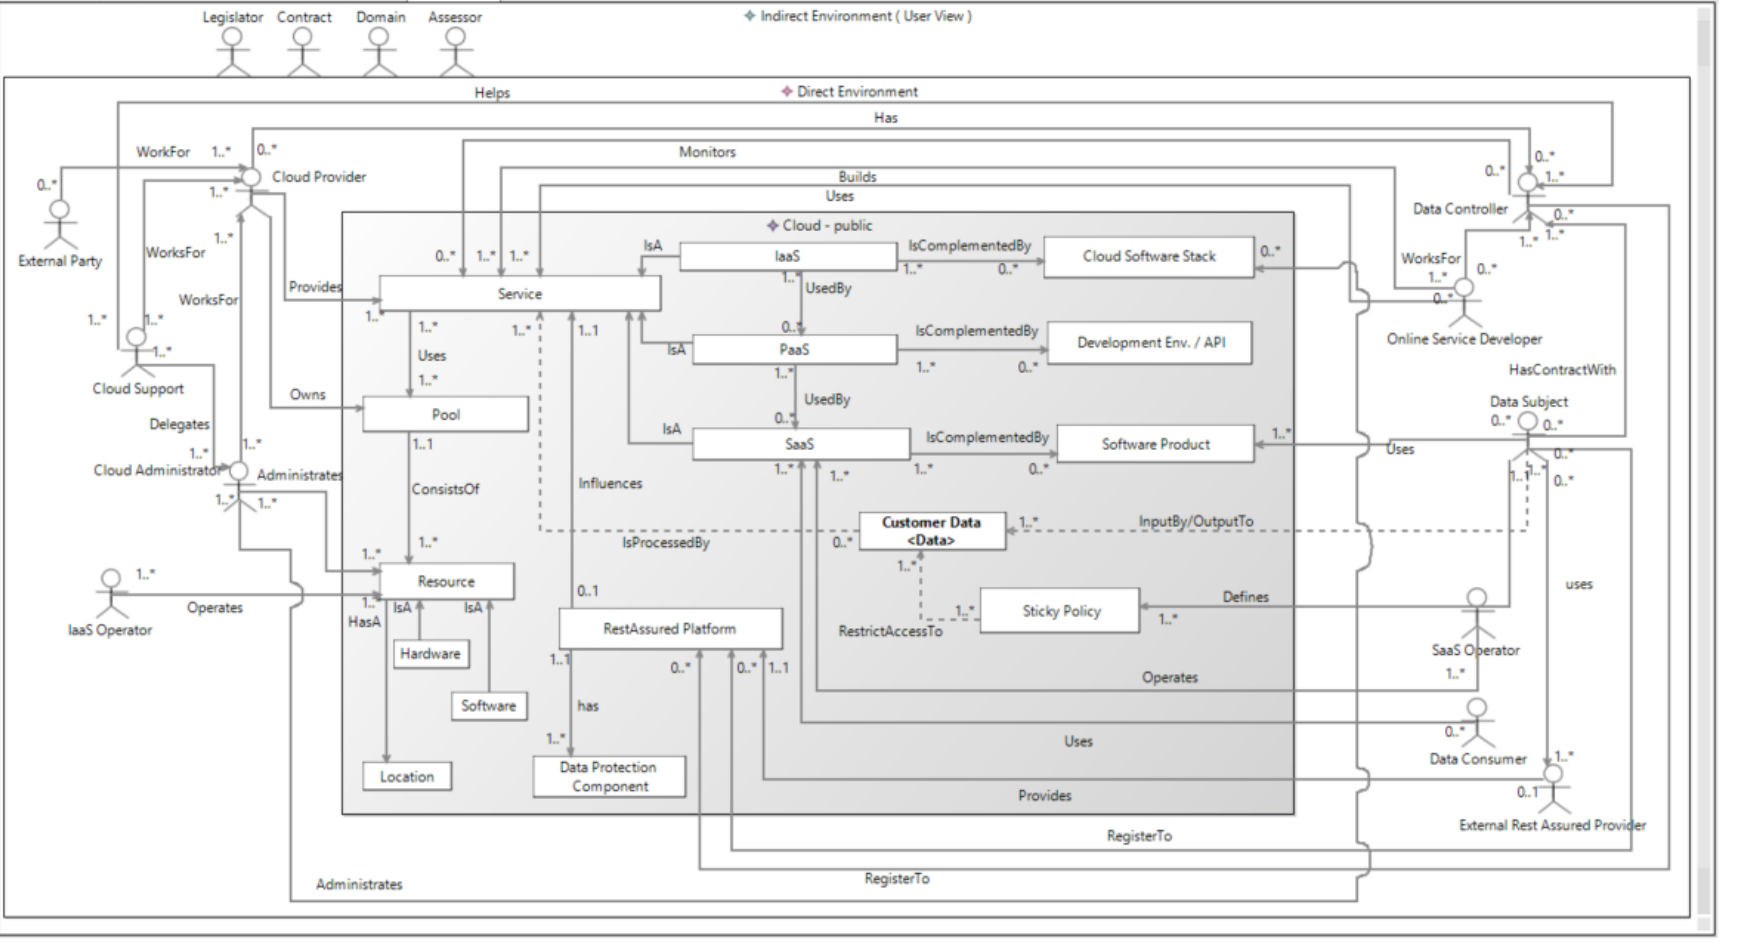
Figure 10. Representation of the instantiated cloud element of the data instance type in a